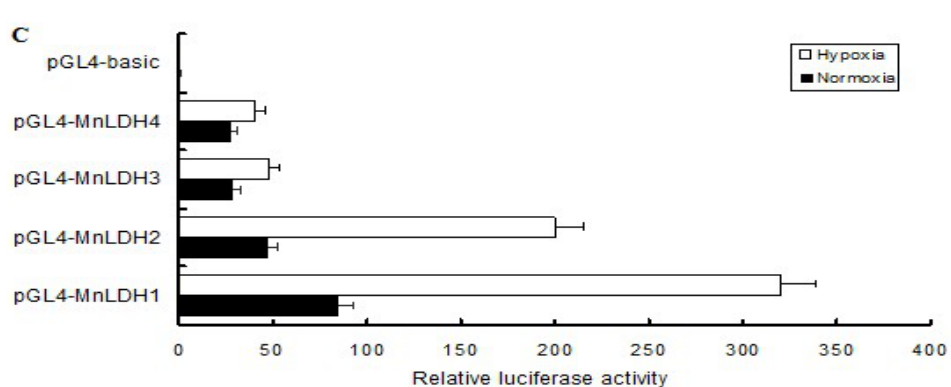
Figure 8. The 5′-flanking sequence of the LDH gene of M. nipponense . Schematic diagram of the gene promoter region ( A ). Putative transcription factor binding sites are underlined and labeled. Putative elements including HIF-1a binding sites (HRE; black bars), DNA detection reaction elements (PRES; blue triangle), a Nkx6B-like homeodomain protein binding site (HGTX; blue large oval), transcriptional inhibitory factor binding sites (HEEX; blue medium-sized oval) and a TATA box (blue small oval) are shown. ( B ) Expression of MnLDH promoter constructs in transiently-transfected insect Sf9 cells. A schematic illustration of the promoter-luciferase reporter constructs is shown on the left, HREs are indicated by I. ( C ) The activity of each construct relative to empty vector (pGL3-basic) in transiently-transfected Sf9. The data are expressed as fold-induction relative to empty vector (pGL3-basic), and the error bars represent ± SE of three replicate trials.